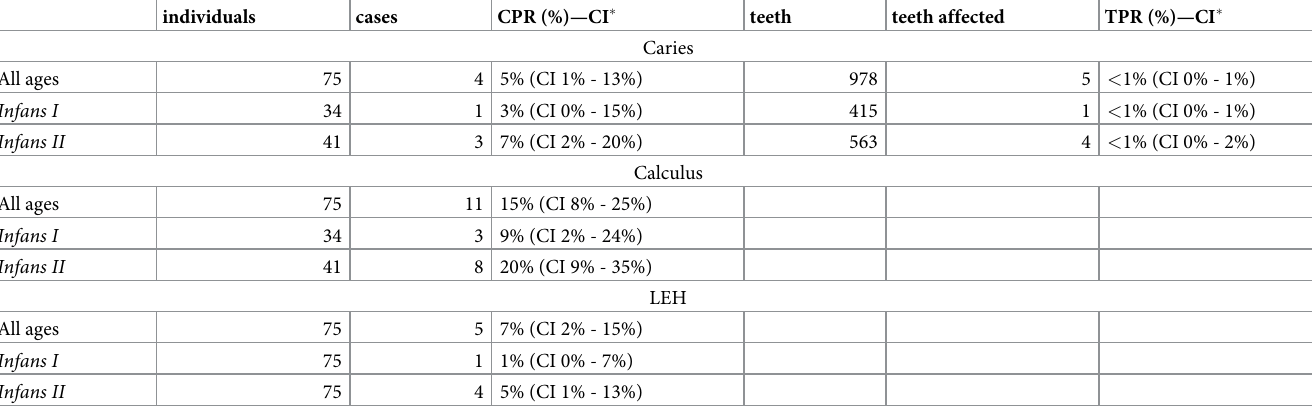
Table 1. Crude prevalence rate (CPR) and true prevalence rate (TPR) of caries, calculus and linear enamel hypoplasia (LEH) separated by age group. individuals